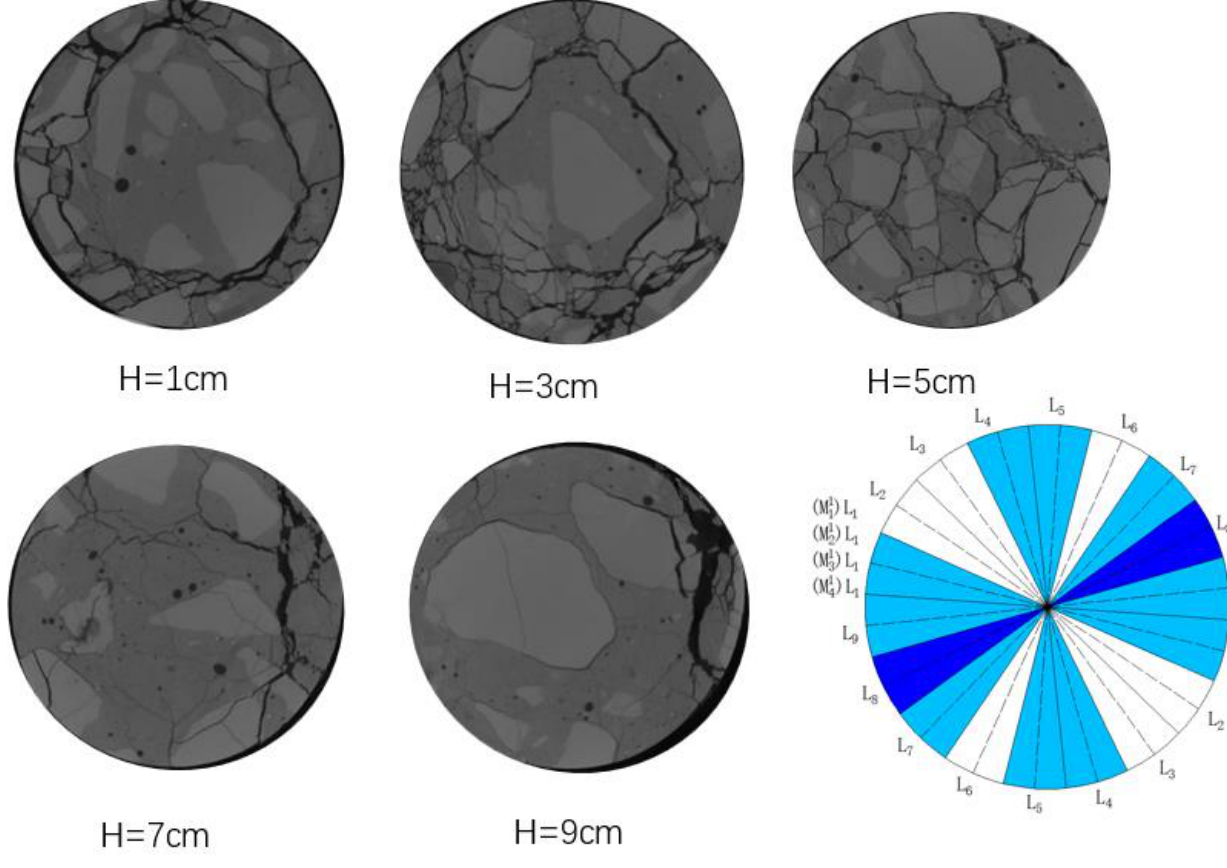
Figure 12. Damage patterns and damage determination results of exposed group.